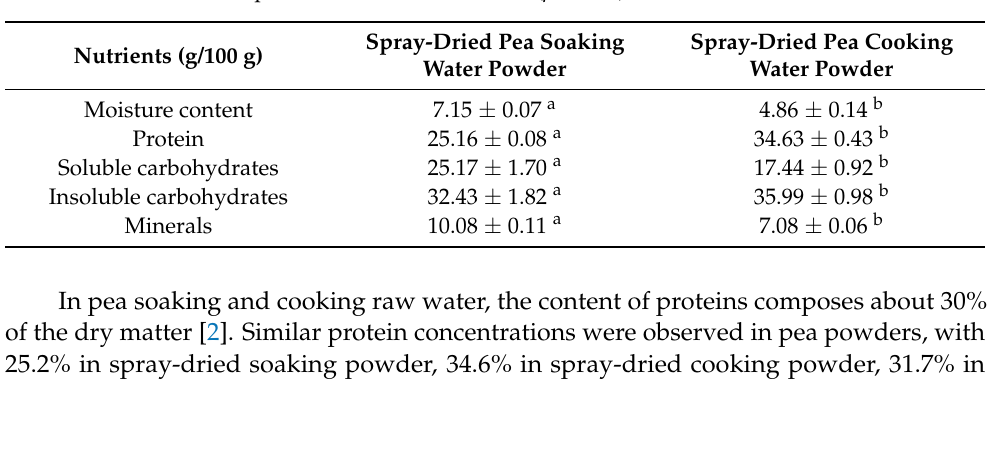
Table 1. Proximate composition of spray-dried pea soaking and cooking water powders. Different letters in the same row represent statistical difference ( p <